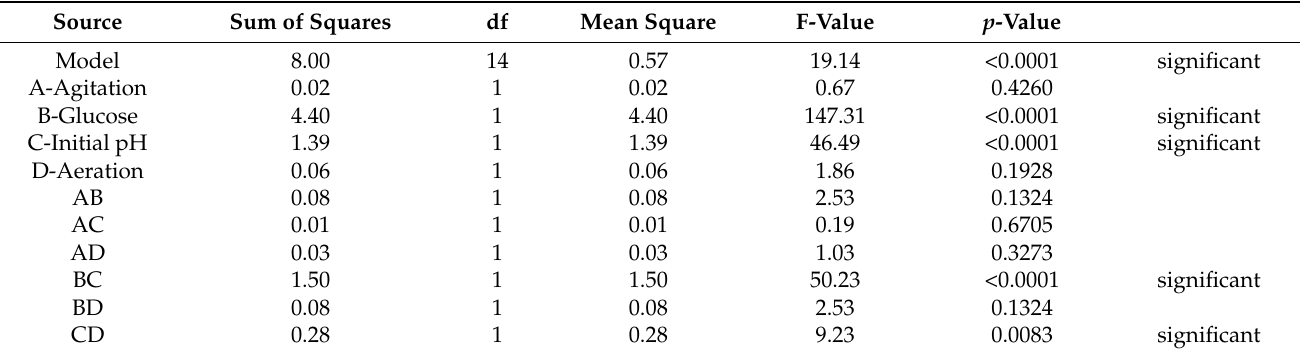
Table 5. The experimental results from the CCD quadratic model for EPS derived from G. lucidum strain QRS 5120 mycelia were subjected to an